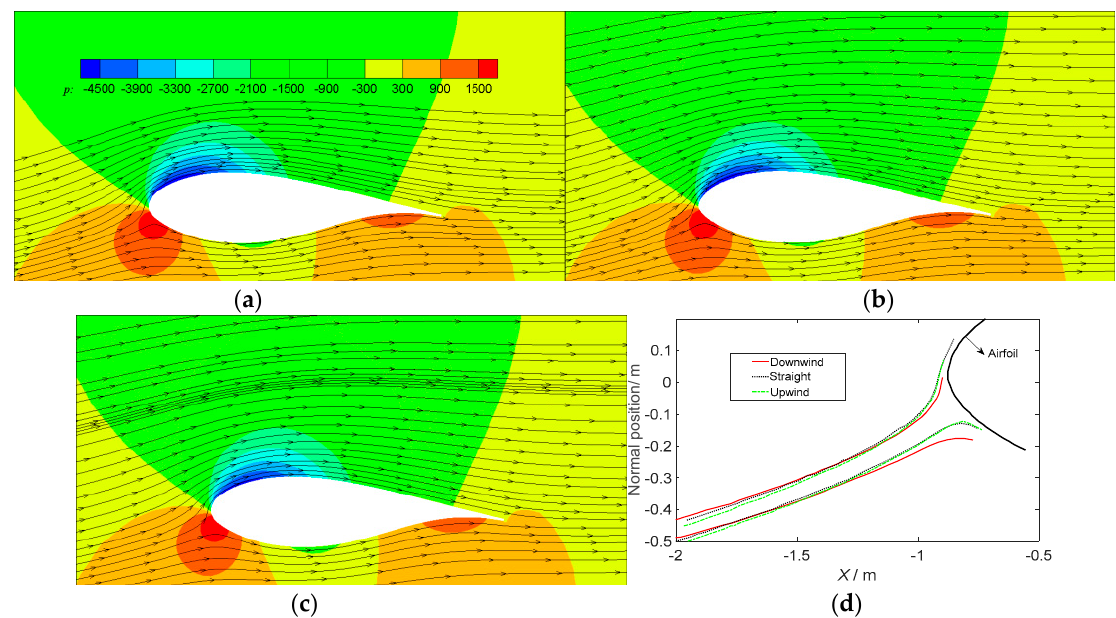
Figure 10. Streamlines and pressure on r = 77.59 m normal-cut plane: ( a ) upwind coning of T trans = 5/ R , C cone = − 4; ( b )